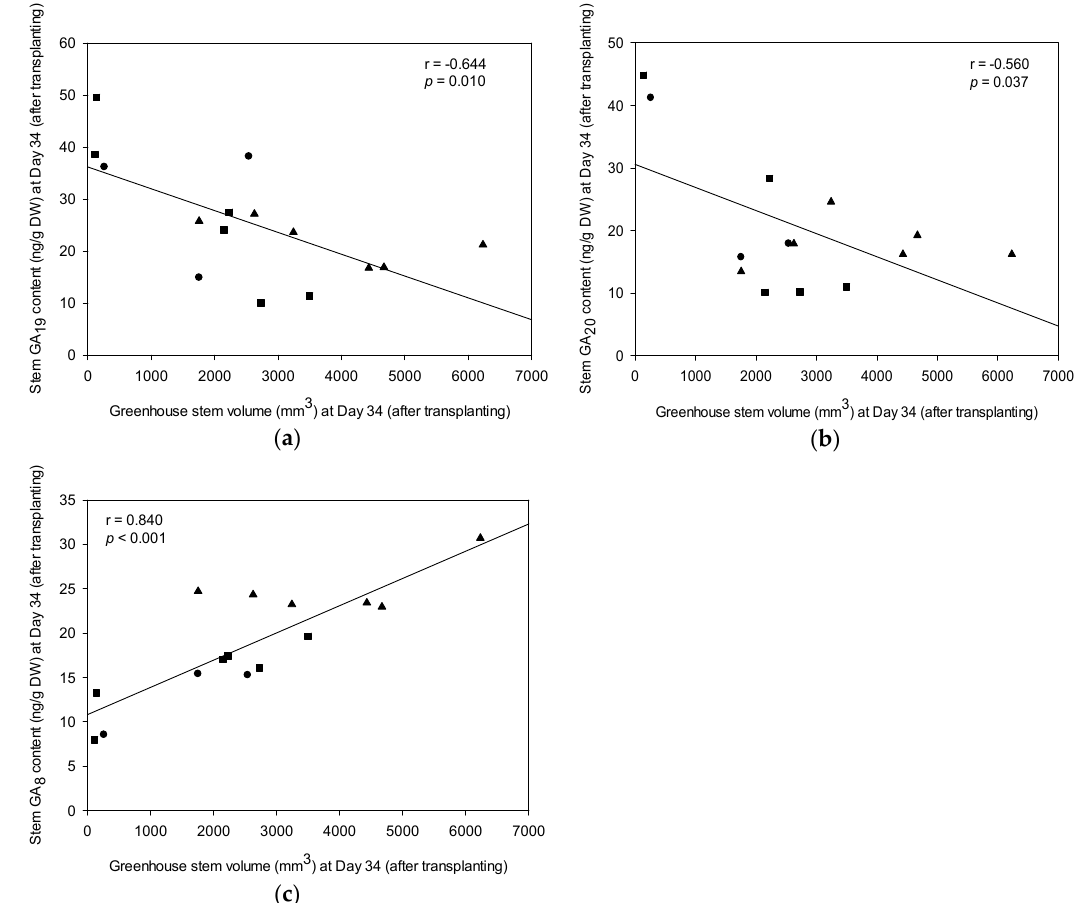
Figure 7. Pearson’s correlation (r) between greenhouse stem volume at Day 34 (after transplanting) and plant hormones for 15 selected progeny; ( a ) GA 19 (ng/g DW); ( b ) GA 20 (ng/g DW); and ( c ) GA 8 (ng/g DW). Symbols represent individual progeny that had been previously grouped with FG ( ▲ ), SFG ( ■ ), and SG ( ● ). Note: SG = slow-growing progeny; SFG = slow-growing progeny from a fast-growing family; and FG = fast-growing progeny.